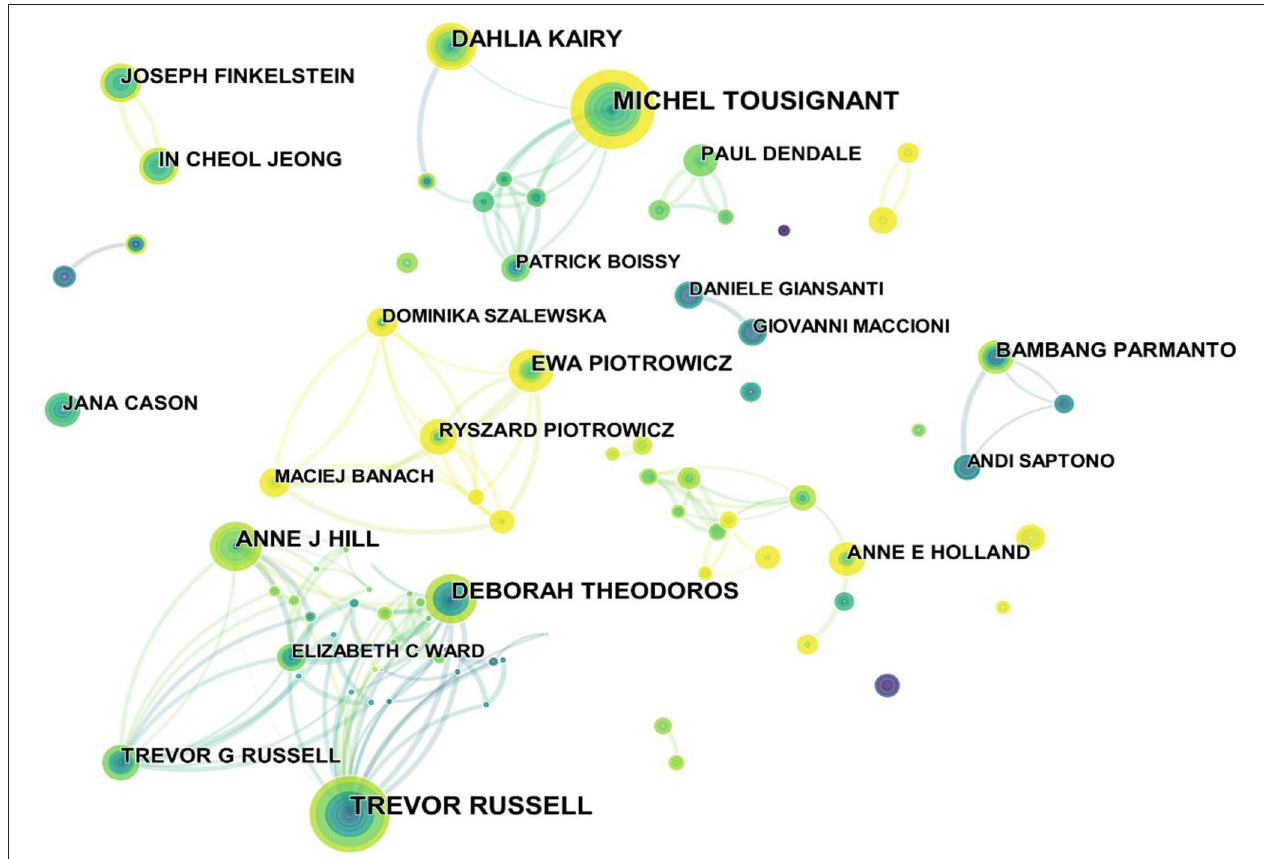
FIGURE 5 | Map of authors related to telerehabilitation from 2000 to